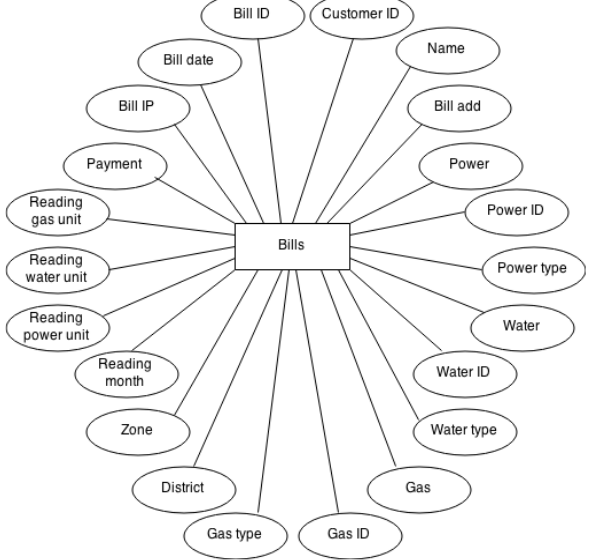
Figure 3. Bill attributes for new system